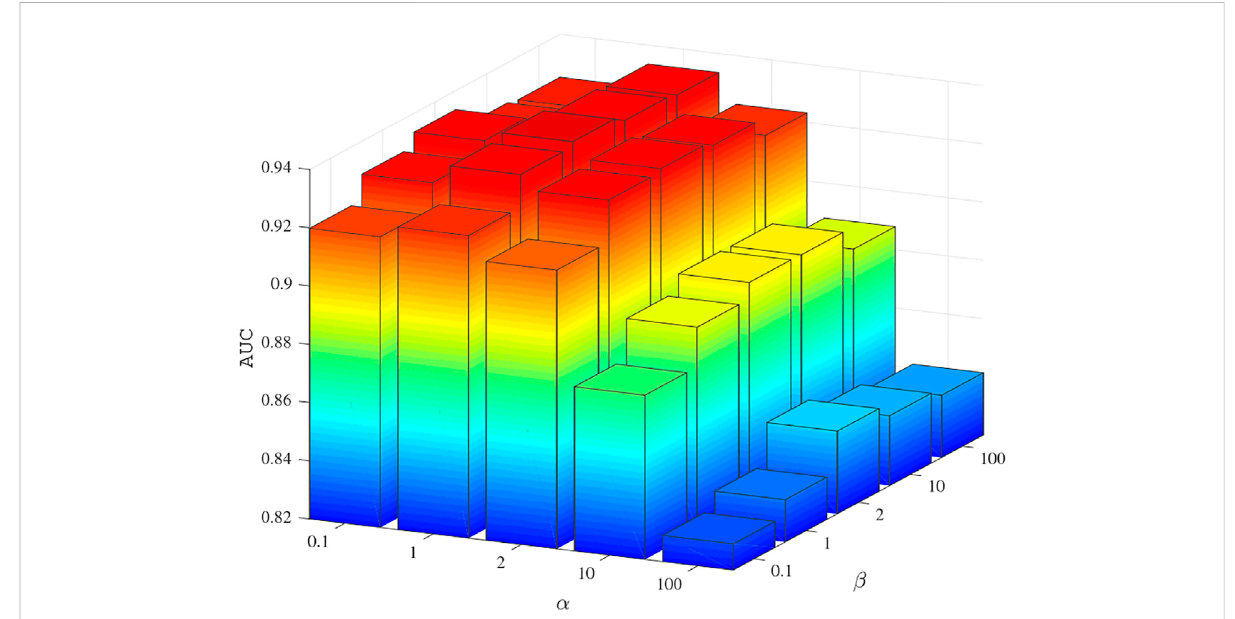
FIGURE 2 The AUC values using different α and β values in fi ve fold CV experiments on the training